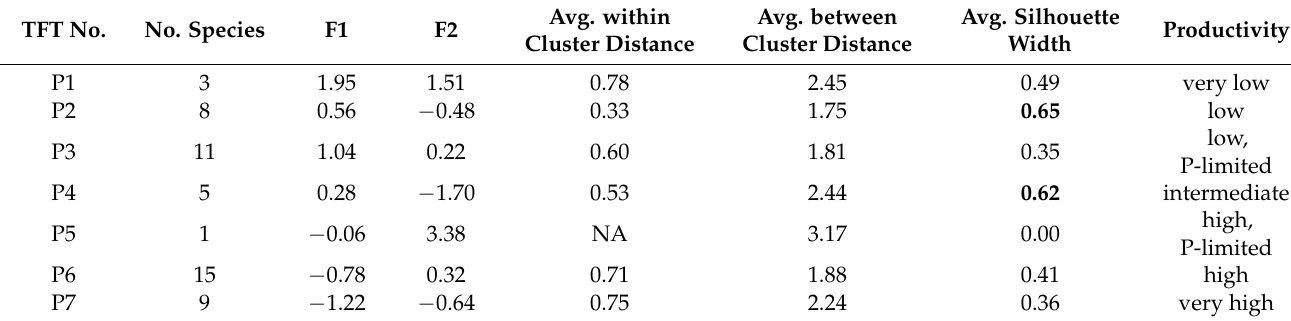
Table 3. Cluster properties and quality metrics of TFTs for the ecosystem function productivity. TFTs are described by their average species factor scores for F1 and F2. TFT size is the number of species assigned to the respective TFT. Bold values of silhouette width represent moderately well-separated and compact clusters. The average within cluster distance could not be calculated for P5, since it only contains one species. TFT